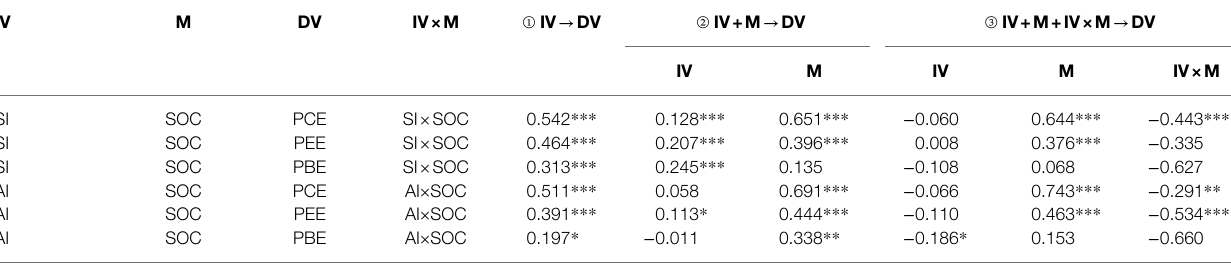
TABLE 8 | Results of the moderating effect testing.